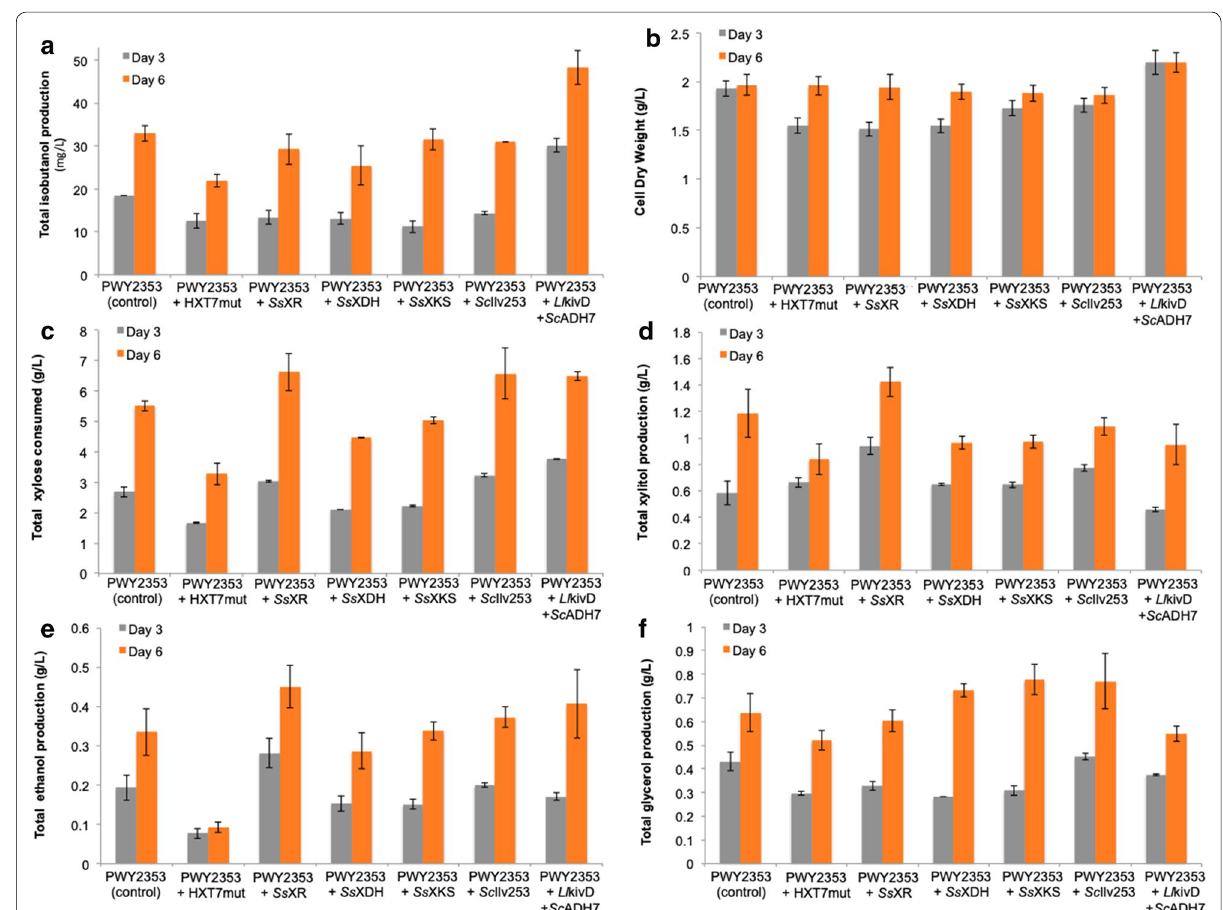
Fig. 4 Characterization of engineered strains with high-copy (2 µm) plasmid-based overexpression of individual pathway genes. Total isobutanol production ( a ), cell dry weight ( b ), xylose consumption ( c ), xylitol production ( d ), ethanol production ( e ), and glycerol production ( f ). Individual gene construct was placed in the pRSII426 plasmid and transform into PWY2353. The resulting strains were cultured in selective medium containing 2% xylose as the sole carbon source. Values are the mean of three biological replicates